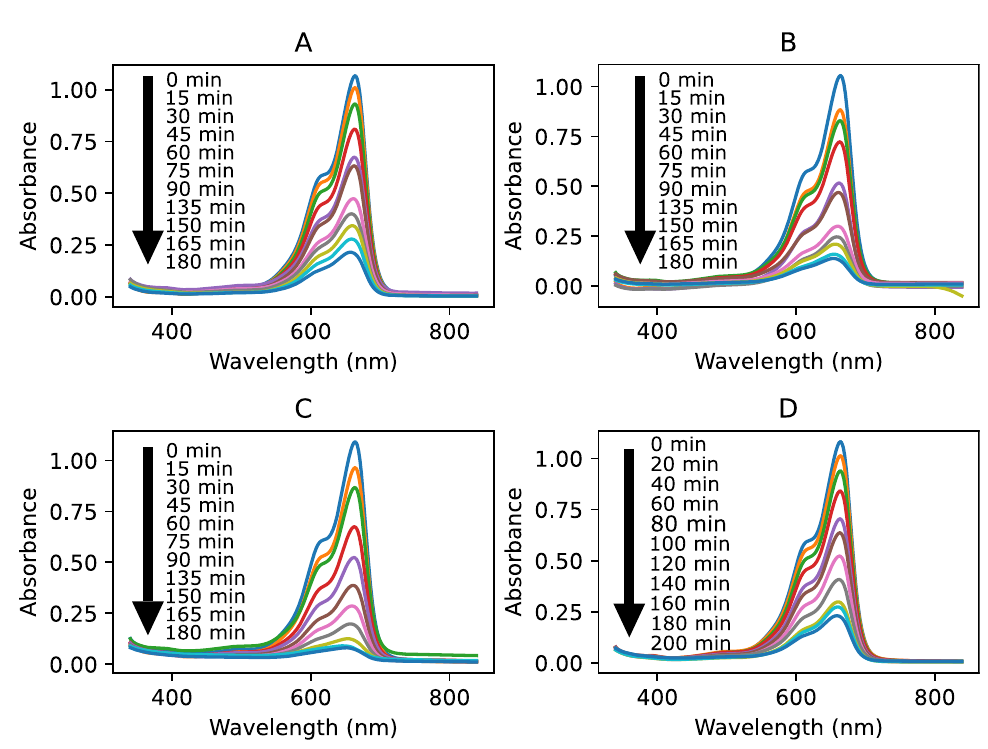
Figure 6 Photodegradation of methylene blue dye measured over its characteristic peak compared with addition of samples (A), (B) and (C) show a fi nal degradation concentration of up to 20.2%, 13.1% and 7.2% respectively, while the dye alone showed a fi nal degradation of 22.1%. Sample A shows lesser photocatalytic ef fi ciency corresponding to its lower absorbance